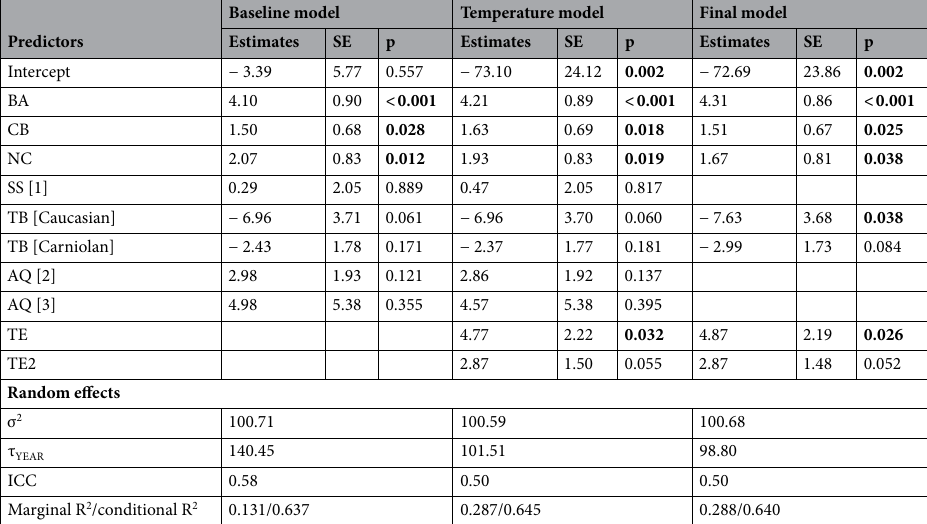
Table 2. Parameter estimates of the baseline, temperature, and final model for V. destructor abundance. Estimates are given for all fixed effects with standard errors ( SE ). For the random effects residual variance ( σ 2 ), the variance associated with tested effects ( τ ), and intraclass correlation coefficient (ICC) are given. Fixed effects of the final model were selected based on the AIC c comparisons. Abbreviations of predictors are given in Table 1. TE is an optimal and TE2 is a suboptimal temperature signal. The number of observations used to fit the models was N = 206 and number of years N YEAR = 22.